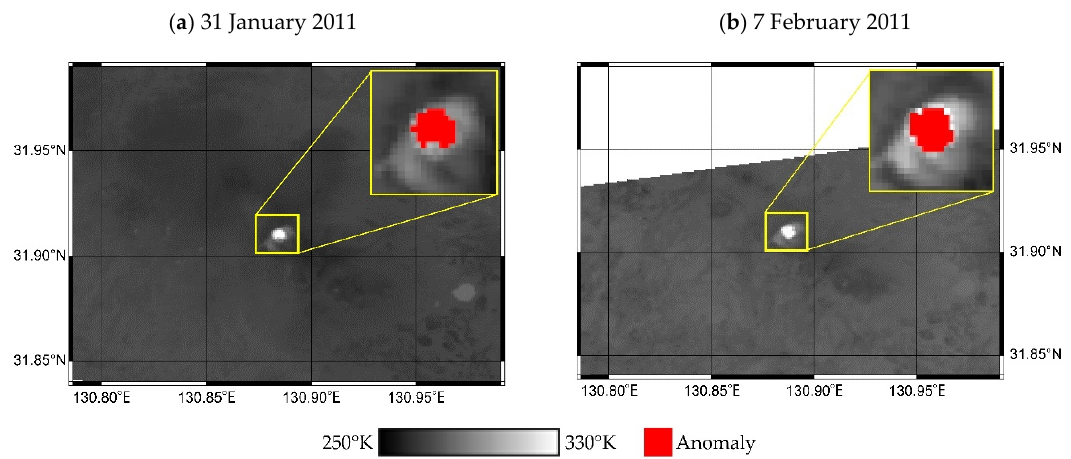
Figure 9. Advanced Spaceborne Thermal Emission and Reflection Radiometer (ASTER) Thermal InfraRed (TIR) data (band 13: 10.25–10.95 µm). ( a ) 13:23:52 on 31 January 2011 (UT) ( b ) 13:29:57 on 7 February 2011 (UT). Red pixels on the zoomed portion indicate anomalous pixels identified by an RST-based analysis on 20 years (2000–2020) of ASTER TIR data.